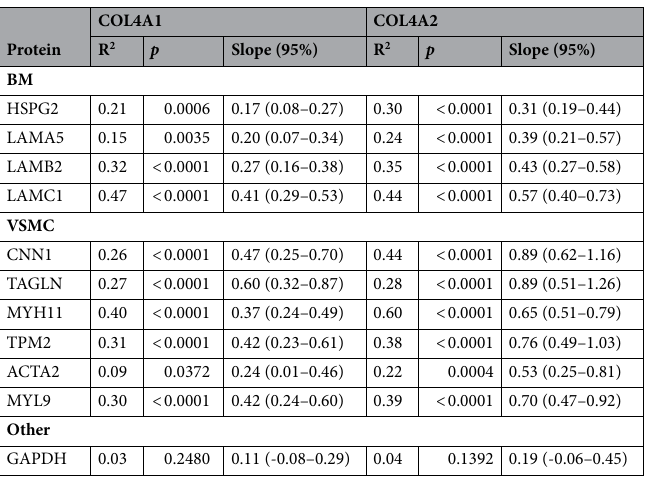
Table 1. Correlations of COL4A1 and COL4A2 to BM proteins and VSMC markers in human ITAs (graphical representation of correlations are shown in Supplementary Fig.